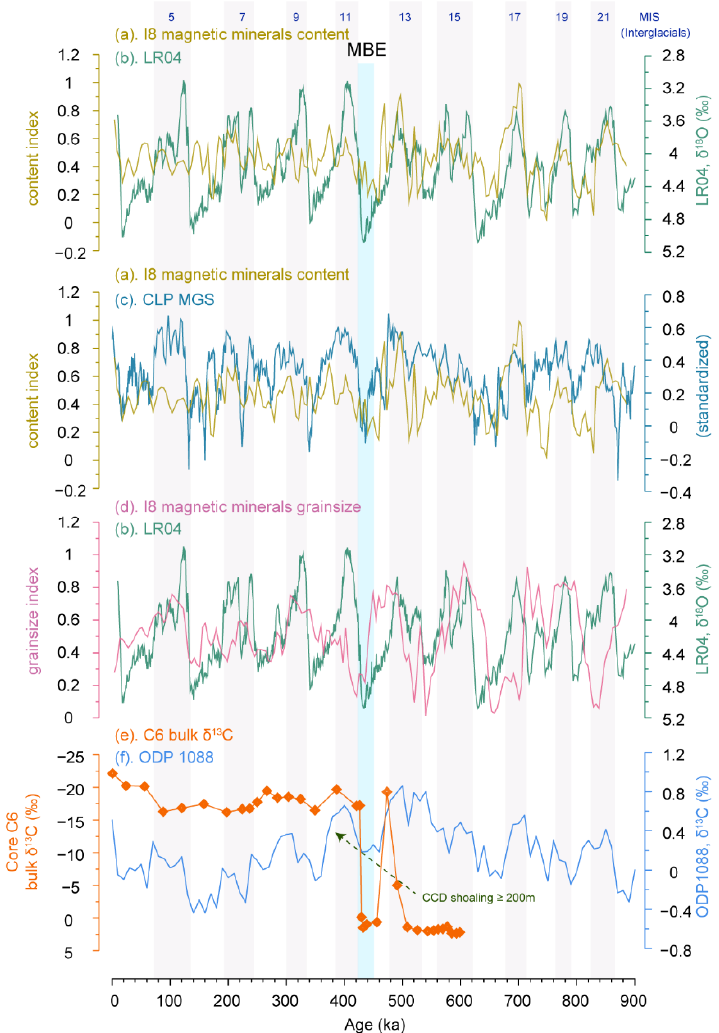
Figure 6. Comparison of various environmental proxies; ( a ), magnetic content index (calculated by χ lf and SIRM); ( b ), the benthic δ 18 O stack LR04 [26]; ( c ), stack grain size (MGS) of China Loess Plateau (CLP) [10]; ( d ), magnetic minerals grain-size index (calculated by χ ARM / χ and χ ARM /SIRM); ( e ), the bulk carbon δ 13 C of core C6 in Western Philippine Sea [18], indicated CCD shoaling; ( f ), Benthic δ 13 C records of ODP Sites 1088, indicating changes in Circumpolar Deep Water [46]. MIS, marine isotope stages, which are labelled as numbers 5–21 on the